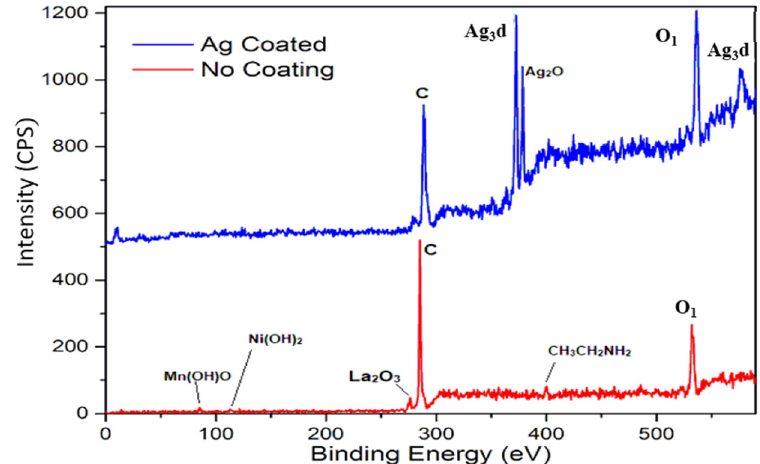
Figure 10. XPS full surface scan of the Ag-coated and virgin pellets.